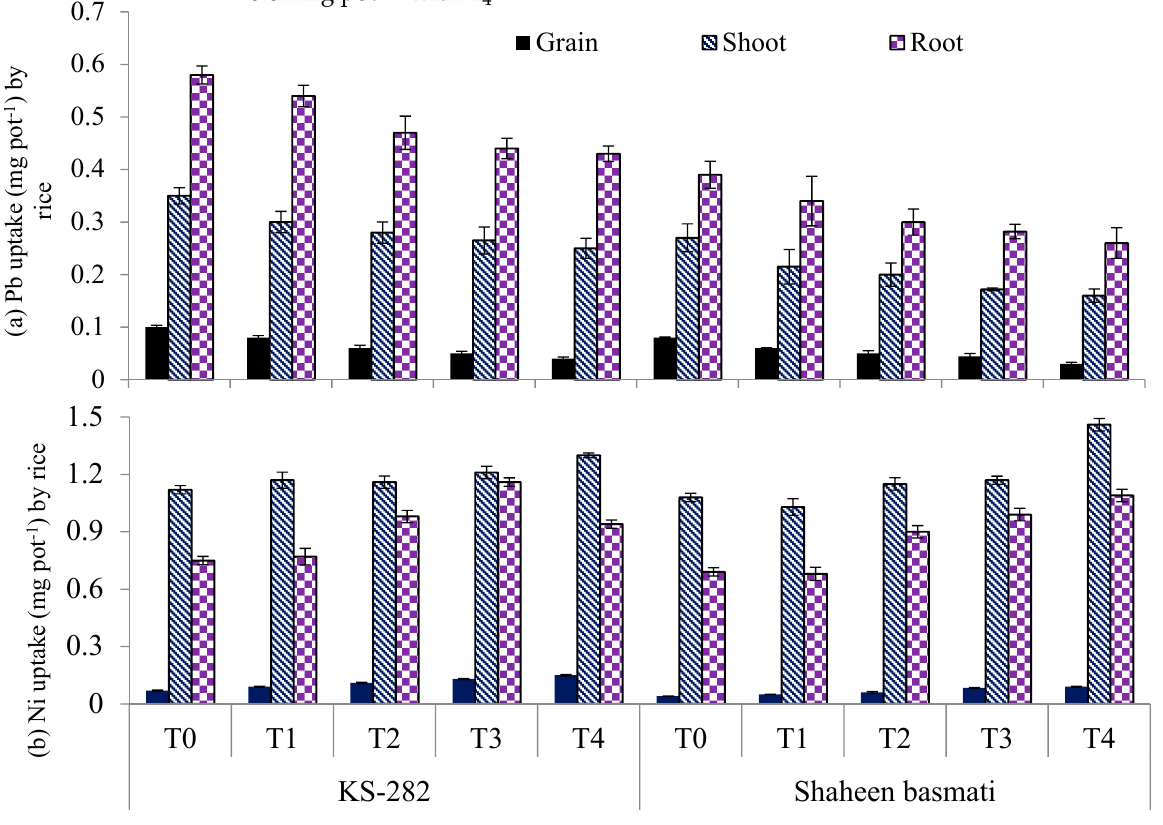
Figure 4. Effect of varying application rates of phosphatic fertilizer on Pb and Ni uptake by rice receiving city effluent irrigation. (Each value is a mean, n = 3 statistically significant at p ≤ 0.05, T bars represents ± SE of means i.e., SEMs). Whereas, T 0 = Control, T 1 = N 170 P 62 K 62, T 2 = N 170 P 124 K 62, T 3 = N 170 P 186 K 62, T 4 = N 170 P 248 K 62.